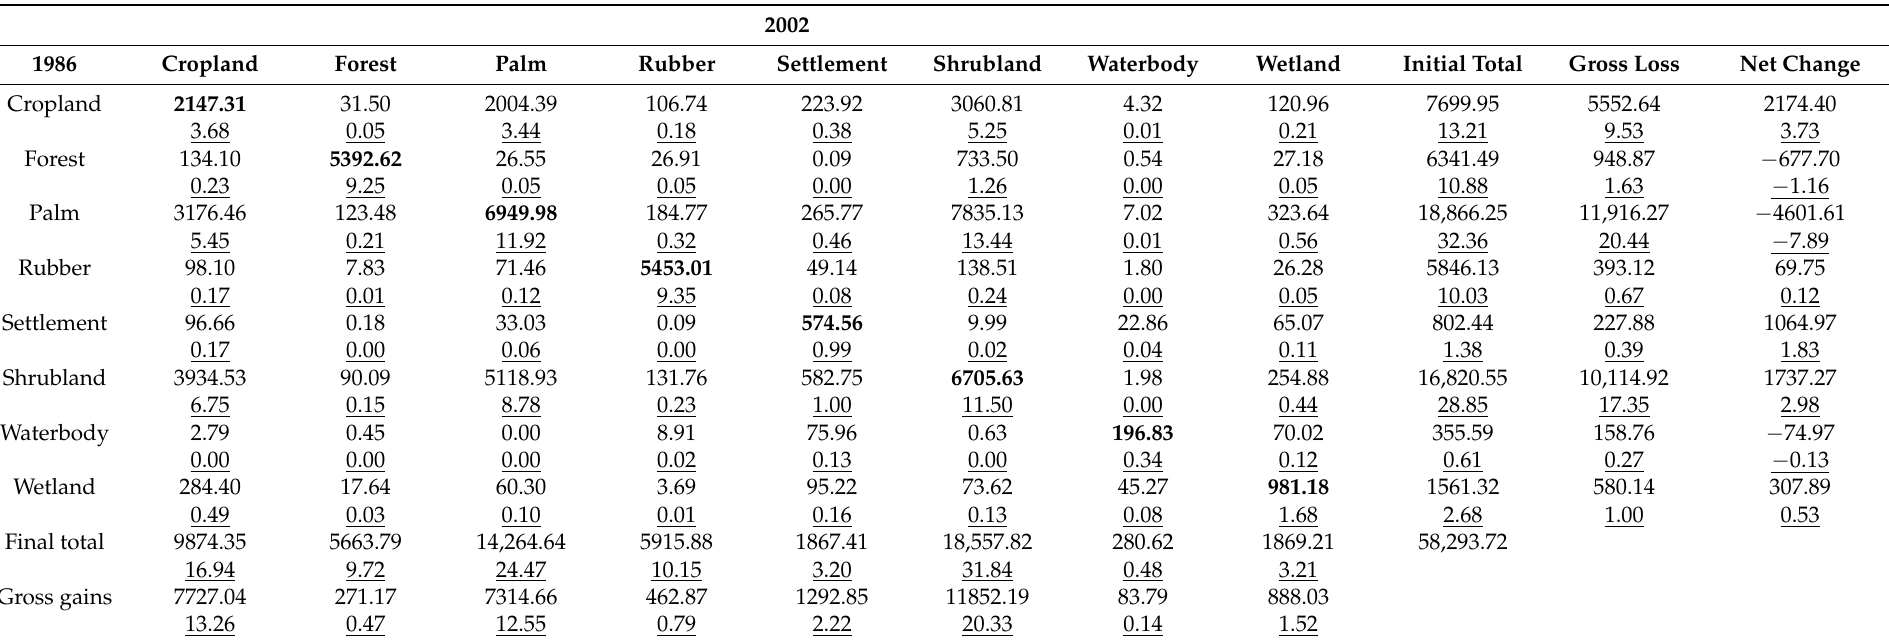
Table A1. Cross tabulation matrices for 1986–2002 area in ha (top values), percentage of total land area (bottom value underlined); the diagonal (in bold) values indicate the persistence of land cover